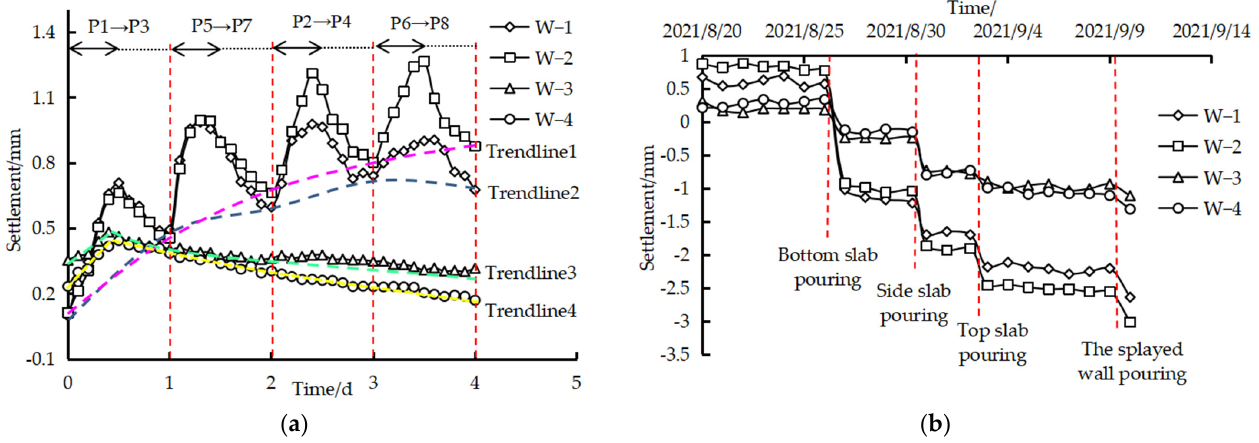
Figure 12. Relation curve of level gauge deformation with the construction time of each stage (Site 2): ( a ) composite foundation treatment; ( b ) culvert extension structure construction.